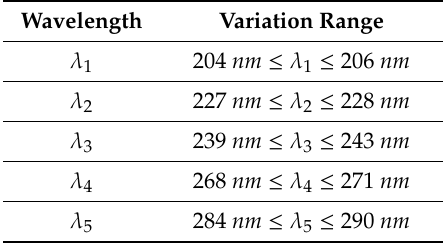
Table 3. The variation range of λ i ( i = 1,2,3,4,5 )